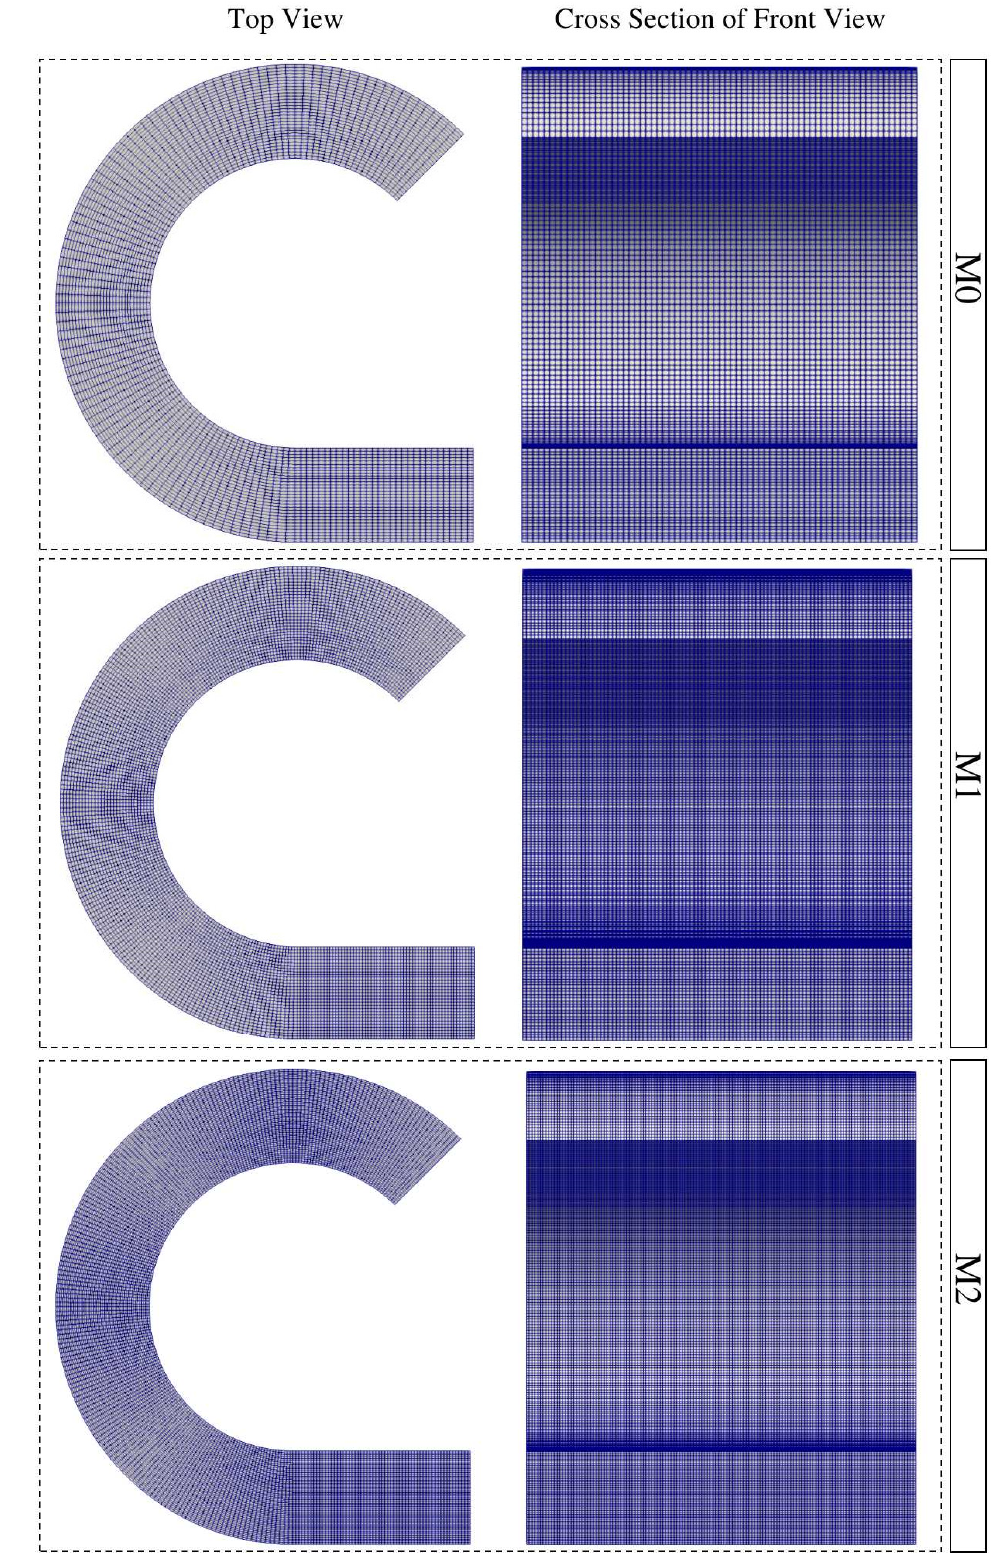
Figure 6. A schematic representation of the different meshes used.